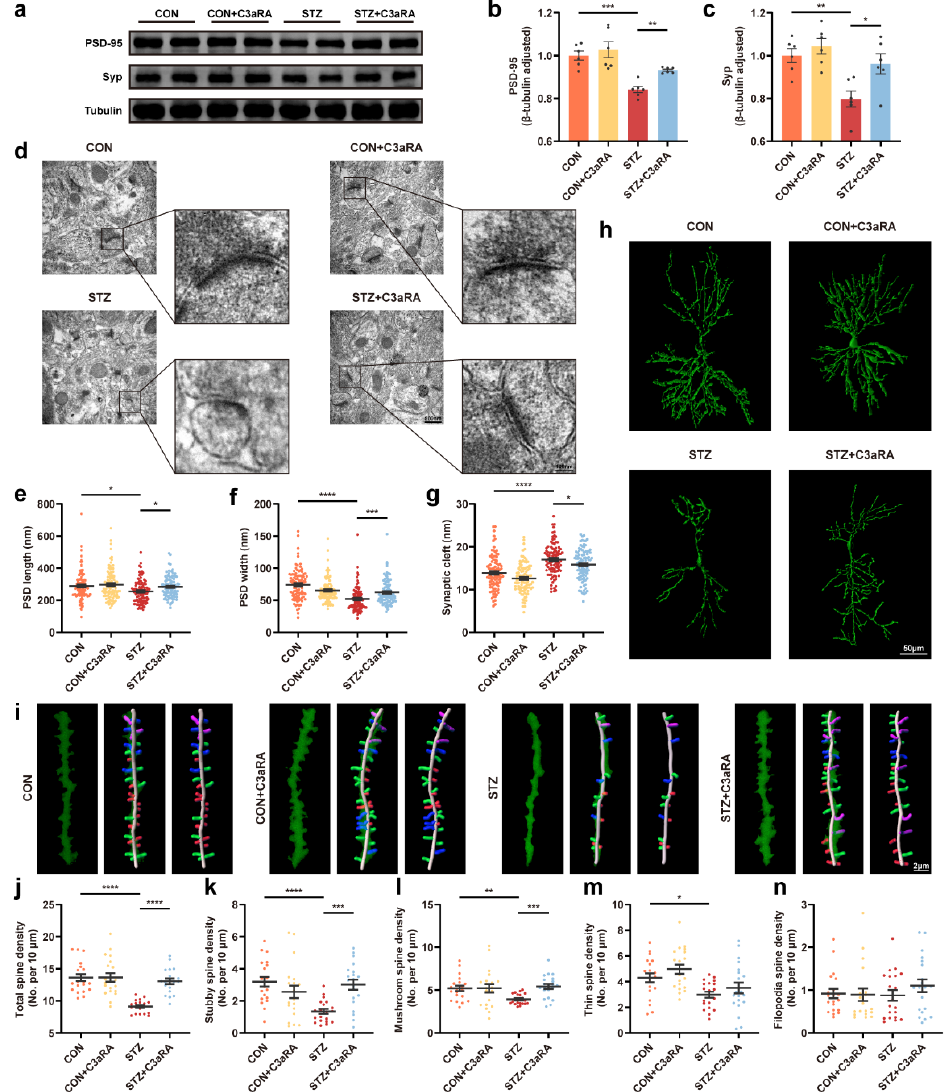
Figure 6. The effect of C3aRA on synapse change in the hippocampus of mice with T1DM. ( a – c ) Representative Western blot images and quantitative analysis of synaptic protein expression in CON, CON + C3aRA, STZ, and STZ + C3aRA mice ( n = 6). ( d – g ) Representative ultrastructure images of synapses ( d ) and quantitation of PSD length ( e ) and width ( f ) and synaptic cleft ( g ) ( n = 95–99; 3 mice per group). The scale bars are 500 and 100 nm. ( h ) Golgi staining images of the neuronal morphology in different groups. The scale bar is 50 µ m. ( i ) Representative three-dimensional re- construction images of different types of hippocampal spines in each group, including stubby (red), mushroom (green), thin (blue), and filopodia (purple) spines. The scale bar is 2 µ m. ( j – n ) Quantitative analysis of spine density, including total ( j ), stubby ( k ), mushroom ( l ), thin ( m ), and filopodia ( n ) spines ( n = 20; 3 mice per group). The data were presented as mean ± SEM and analyzed via one-way ANOVA with Tukey’s multiple comparison tests, Welch’s ANOVA with Dunnett’s T3 mul- tiple comparison tests, and Kruskal-Wallis test with Dunn’s multiple comparison tests. * p < 0.05; ** p < 0.01; *** p < 0.001; **** p < 0.0001. C3aRA, complement component 3a receptor antagonist; T1DM, type 1 diabetes mellitus; CON, control mice; STZ, mice with T1DM; PSD, postsynaptic density; Syp,